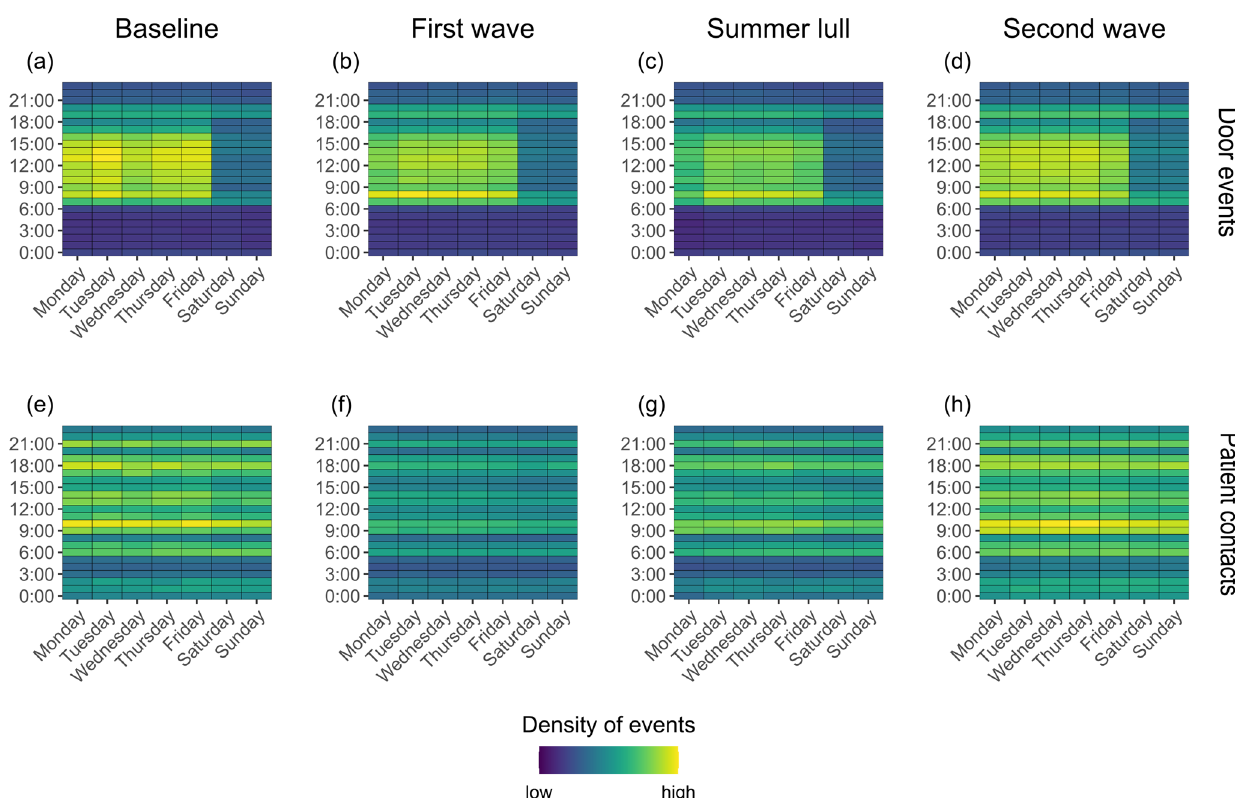
Fig. 2 Heat maps for the hourly activity of healthcare workers in the Tower building of University College London Hospital during the fi rst year of the COVID-19 pandemic. The hourly density of events throughout the week are plotted for the number of door events ( a – d ) and number of patient contacts ( e – h ) during the baseline period (pre-pandemic), fi rst wave, summer lull and second wave. Yellow cells represent a relatively high density of events and blue cells represent a relatively low density; to allow comparison between each stage of the pandemic, the colour gradient is relative to the maximum weight across all time periods for each metric